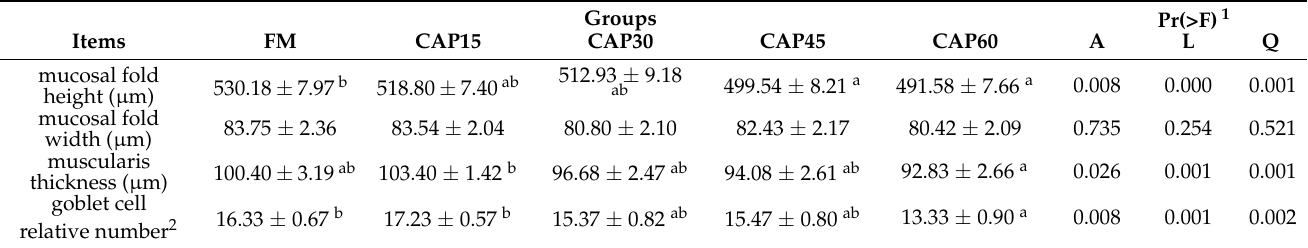
Table 7. Distal intestinal morphological histology of pearl gentian grouper-fed gradient substitution of fishmeal in the diet with CAP (HE-stained sections).